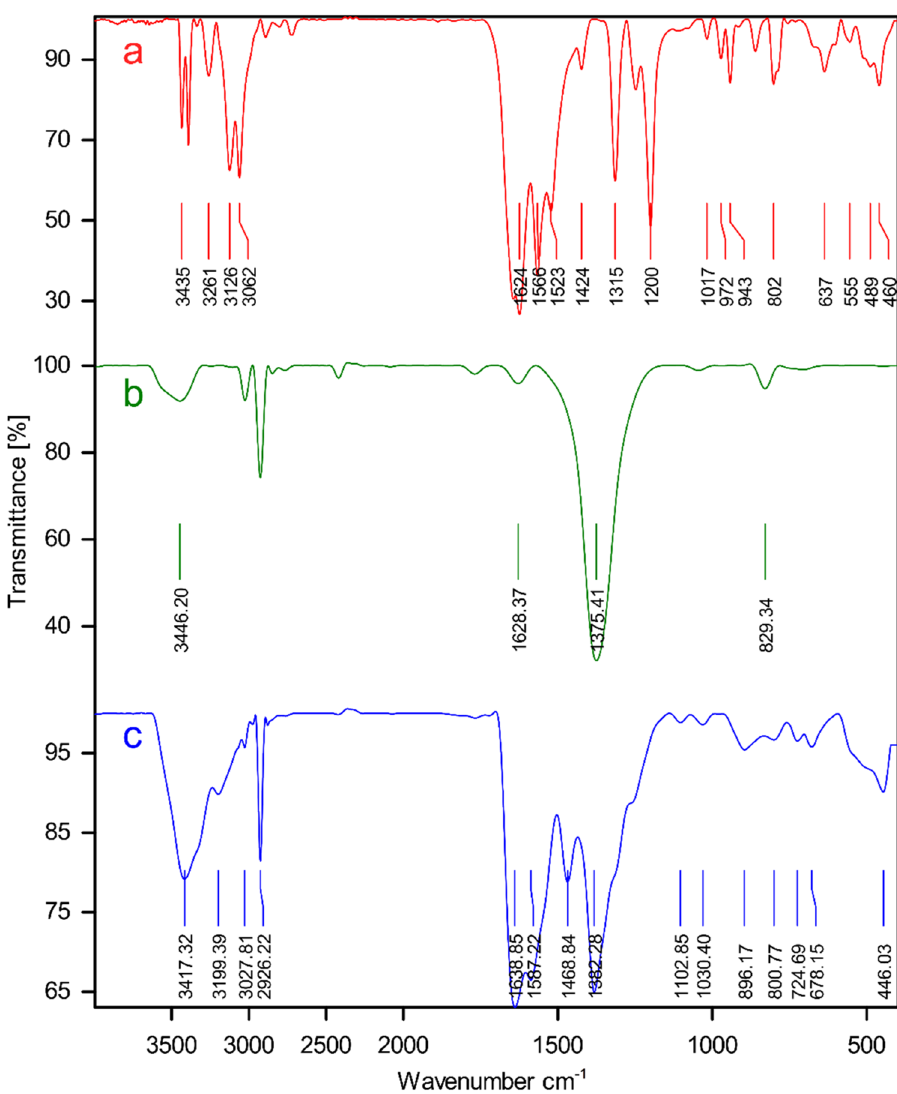
Figure 1. FT-IR Spectrums of ( a ) 4,6-Diamino-2-pyrimidinethiol, ( b ) Zn(NO 3 ) 2 ·6H 2 O and ( c ) nanoporous Zn-MOF